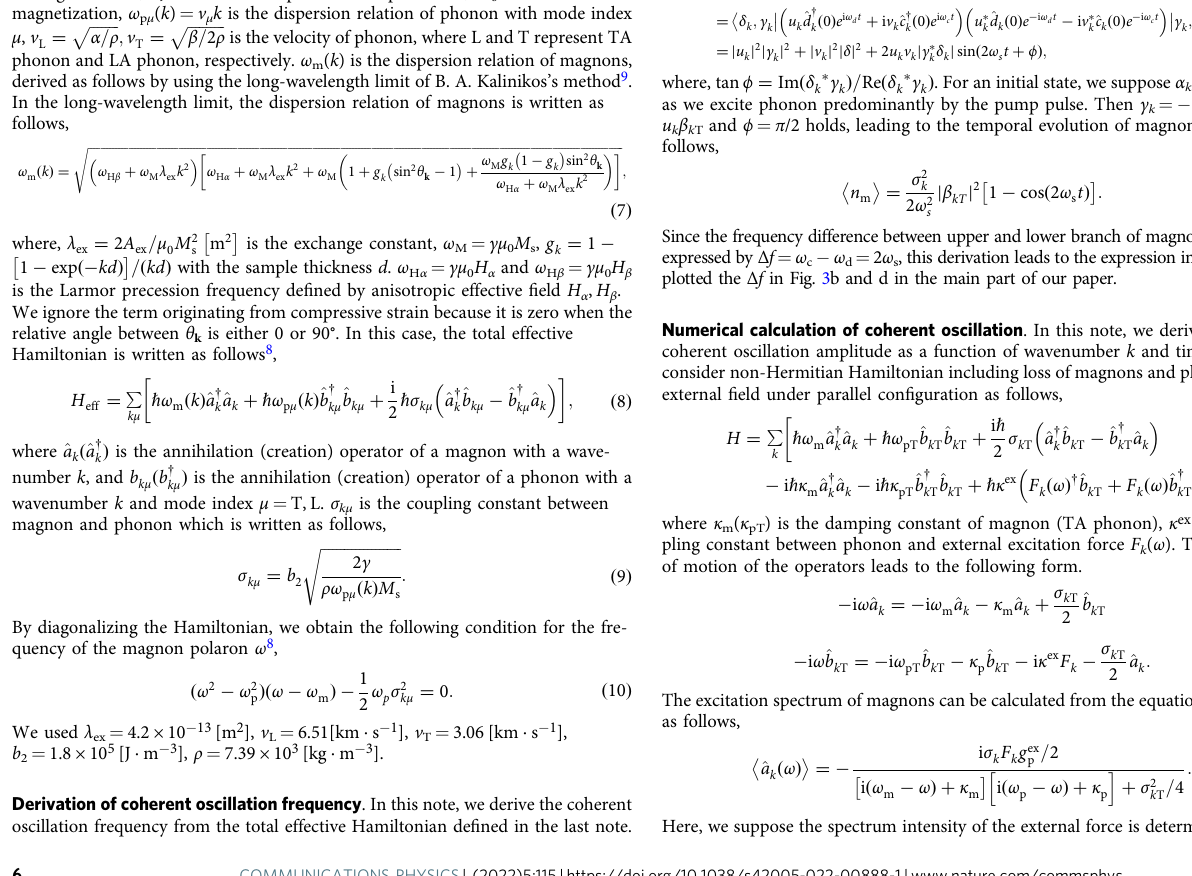
ffiffiffiffiffiffiffiffiffiffi β = 2 ρ